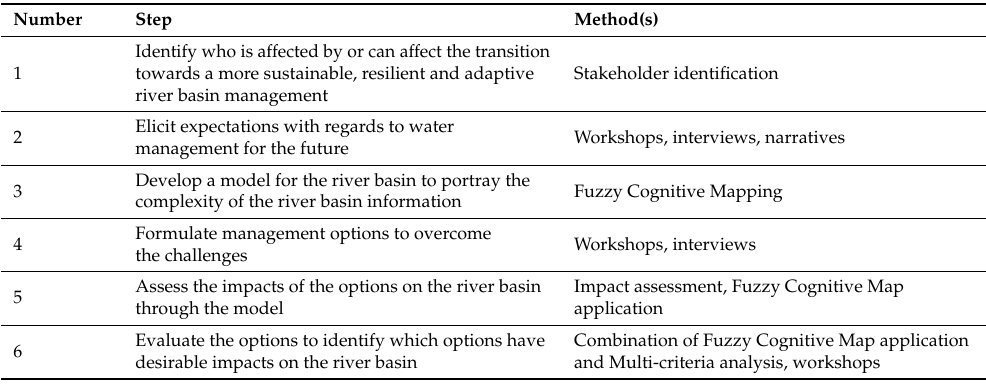
Table 2. Steps in the approach to involve society in the formulation and evaluation of river basin management